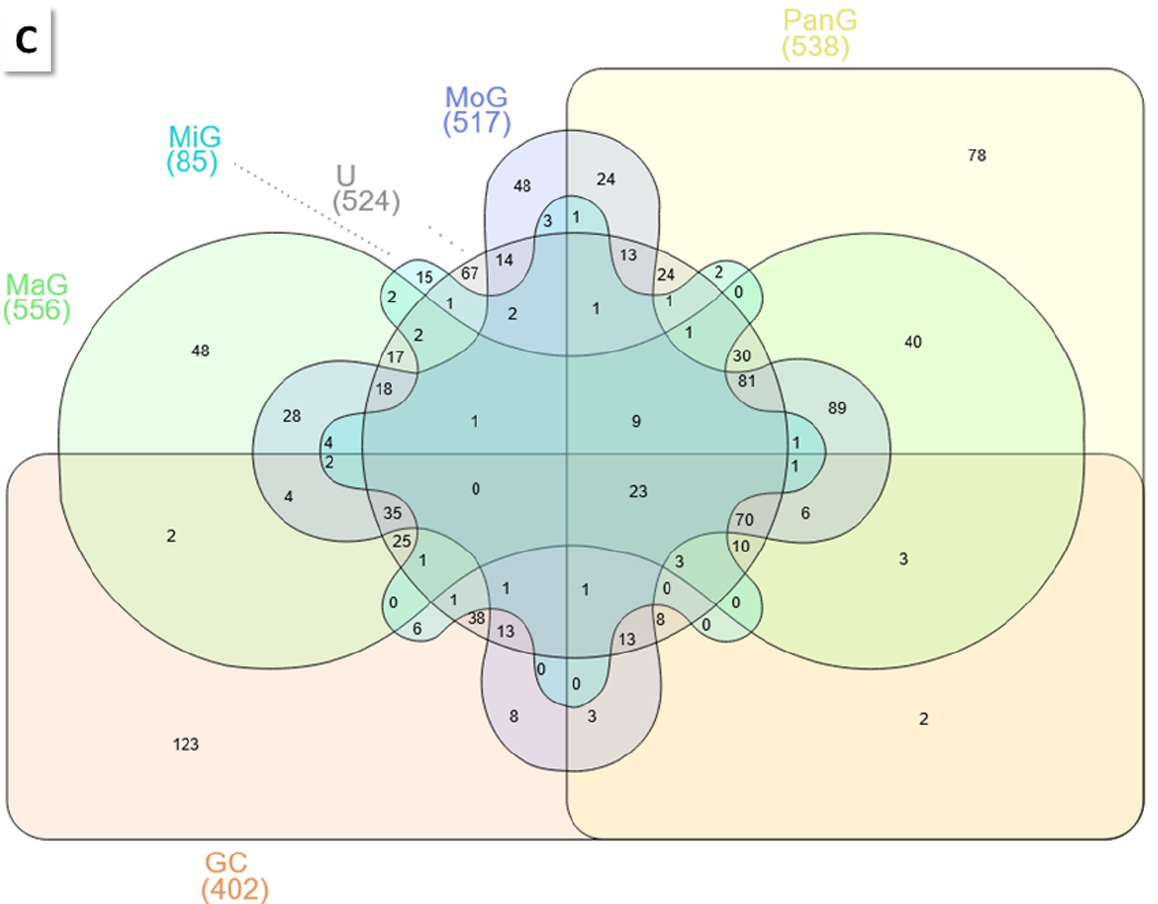
Figure 2. Comparative biopsy analysis. ( A ) PCA of combined MoG and MaG (blue) and PanG (purple) shortlisted proteins, compared to NGM (green) and GC (orange), demonstrate the separation of gastritis protein profiles. ( B ) Venn diagrams showing the number of shortlisted proteins common among the different biopsy groups. Proteins with ( B ) higher and ( C ) lower concentration than in NGM.